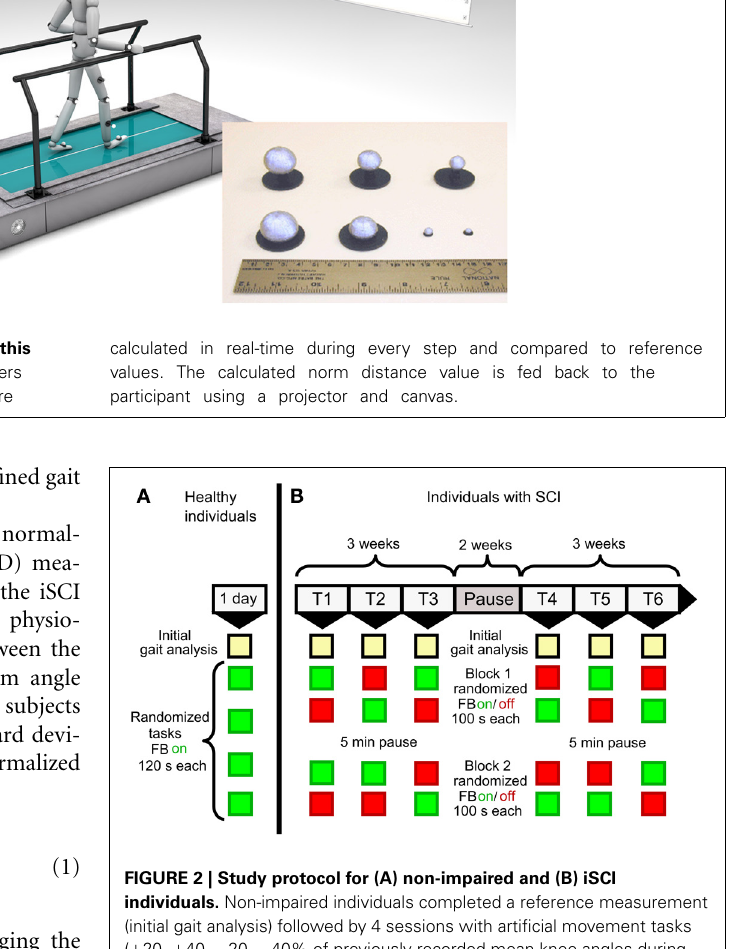
FIGURE 2 | Study protocol for (A) non-impaired and (B) iSCI individuals. Non-impaired individuals completed a reference measurement (initial gait analysis) followed by 4 sessions with artificial movement tasks ( + 20, + 40, − 20, − 40% of previously recorded mean knee angles during normal walking) in randomized order. Individuals with iSCI completed 6 weeks (1 training day per week, two blocks of feedback/ no-feedback sessions per day of training) of FB training with a pause after the third week. Those blocks were randomized, except for the first block of the first day of training, which started with a FB session. Equivalent to the condition in the non-impaired participants each session started with an initial gait